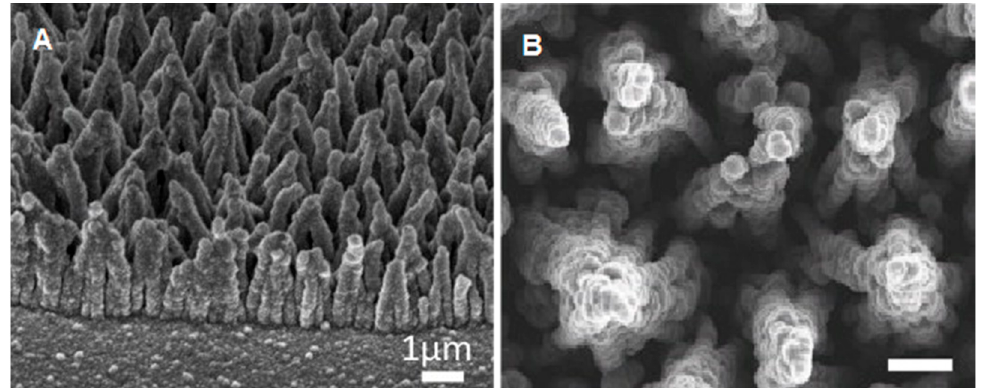
Figure 7. SEM image of the 3D-nanostructured BDD MEA, ( A ) viewed from the side to show the interface of the BDD and the 3D-nanostructured BDD, and ( B ) viewed from the top to show the topography (Scale bar = 600 nm). Adapted from Piret et al . [46] under a Creative Commons licence.